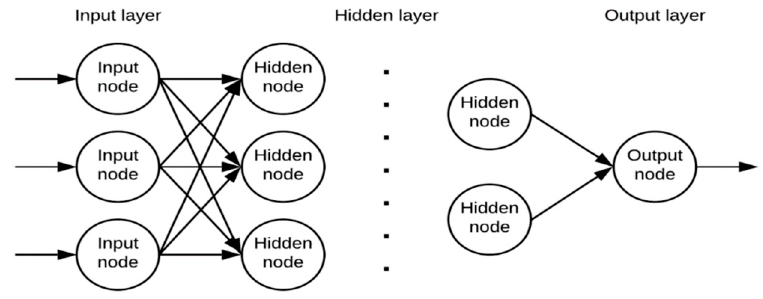
Figure 3. Typical artificial neural network.